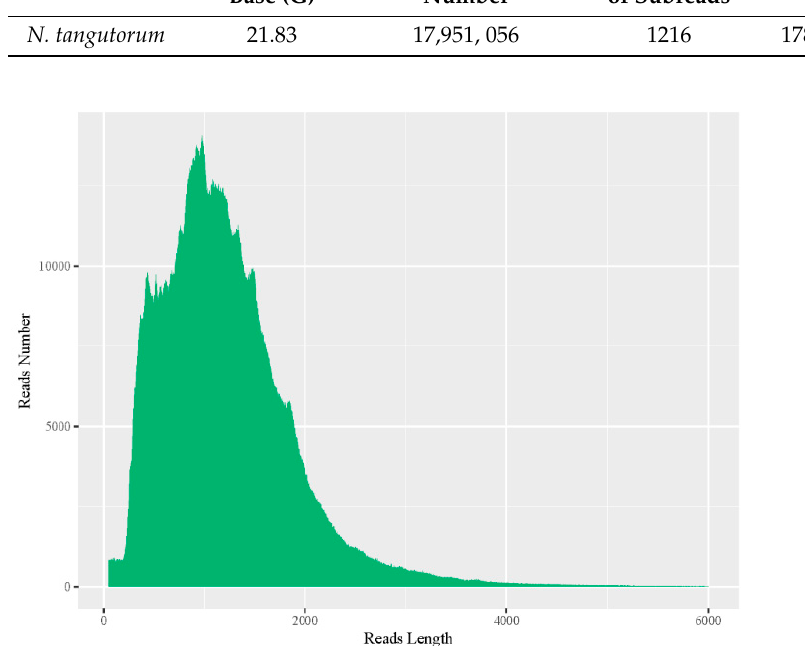
Figure 1. Distribution of subread length. The abscissa is the length of the subreads, and the ordinate is the number of subreads of a particular length.